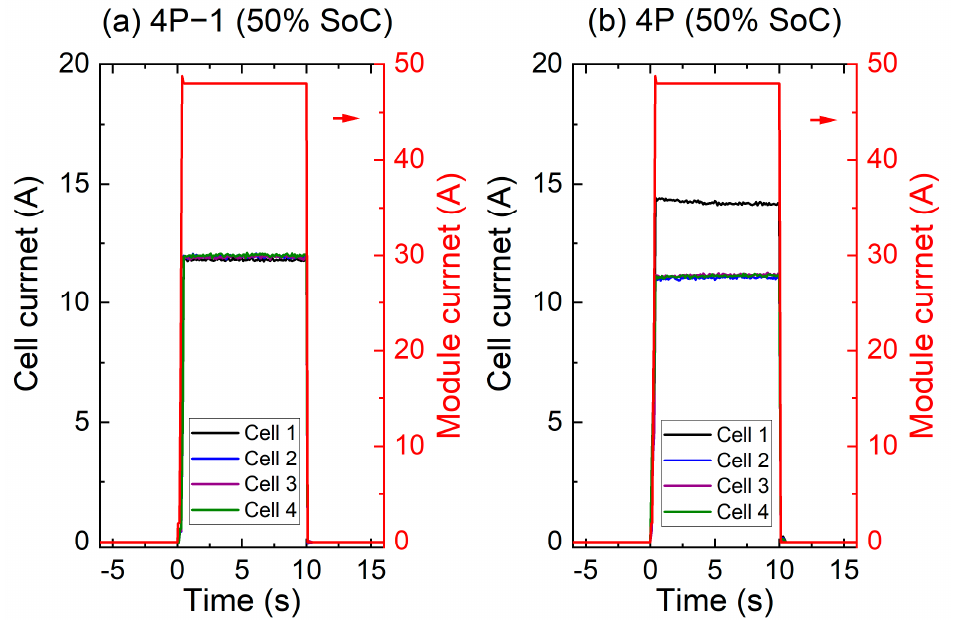
Figure 5. Pulse power test results showing current distribution within the cells at 50% SoC in the parallel connected ( a ) 4P − 1 module with air cooling at 20 °C ( b ) 4P module with an active liquid cooling (for cells 2, 3 and 4) at 20 °C and cell 1 was maintained at an ambient temperature 30 °C. There was no distinguishable current distribution gradient across the cells for configuration 4P − 1 (Figure 5a). In configuration 4P (Figure 5b), cell C1 takes a larger proportion of current as it was at a higher temperature of 30 °C, therefore lower resistance. These observations follow the current distribution behaviour observed for capacity tests. In the 4P configuration, C2, C3 and C4 should present the same resistance value for a particular SoC as they maintained at 20 °C; which was the case, resistance values for C2, C3 and C4 were within 1% variation at any particular SoC.